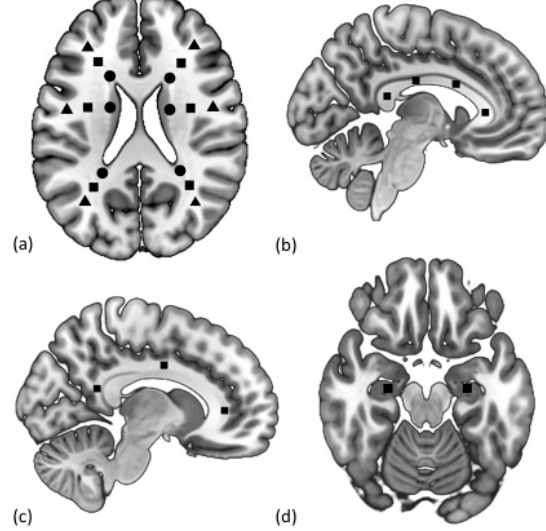
Figure 1. Selection of the regions of interest (ROIs) in the periventricular (circle), deep (square), and juxtacortical (triangle) normal-appearing white matter (NAWM) ( a ); anterior, mid-anterior, mid-posterior, and posterior corpus callosum (CC) ( b ); anterior, middle, and posterior cingulum bundle (CB) ( c ); and hippocampi ( d ).